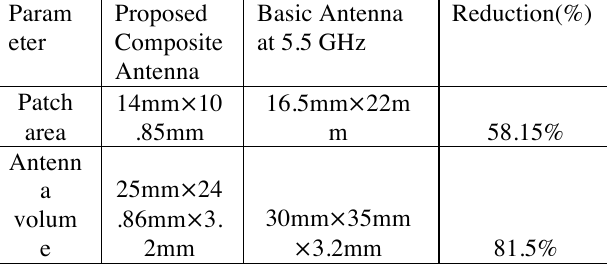
Table 1: Reduction % comparison between basic Antenna